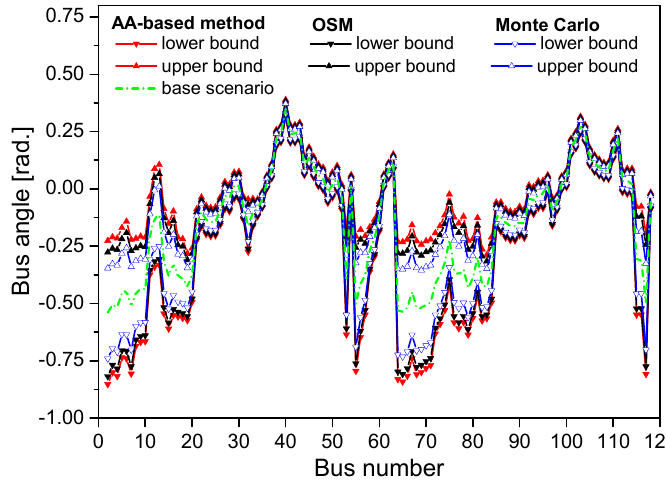
Figure 12. Bus angle results obtained by different methods. Energies 2018 , 11 , 3176